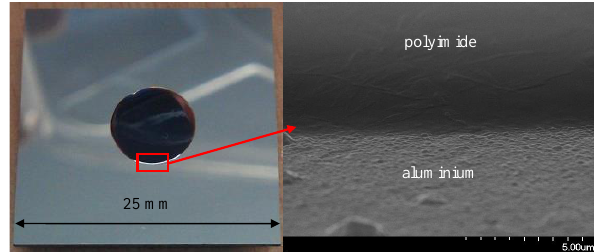
Figure 9. Photograph of a test chip (left) and SEM image of the transition region at a 45 ◦ angle (right).